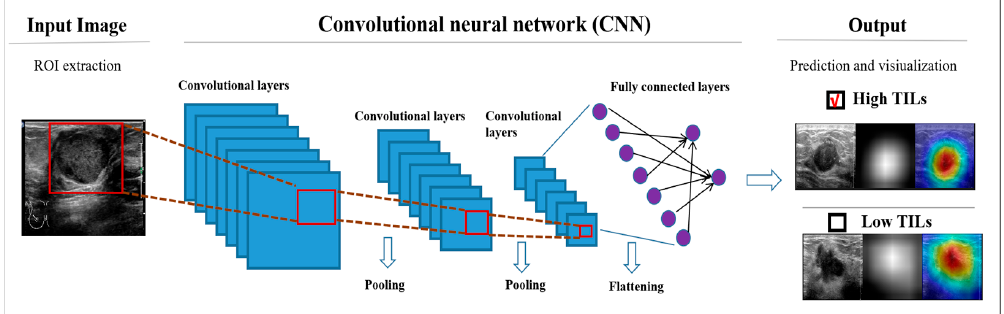
Figure 2. Schematic diagram of the DL models. US, ultrasound; TIL, tumor-infiltrating lymphocyte; ROI, region of interest.